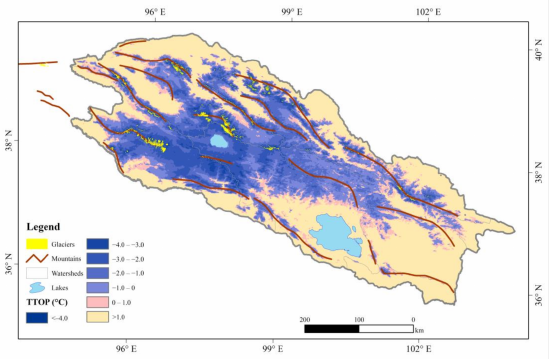
Figure 4. Spatial distribution of the TTOP in the Qilian Mountains averaged during